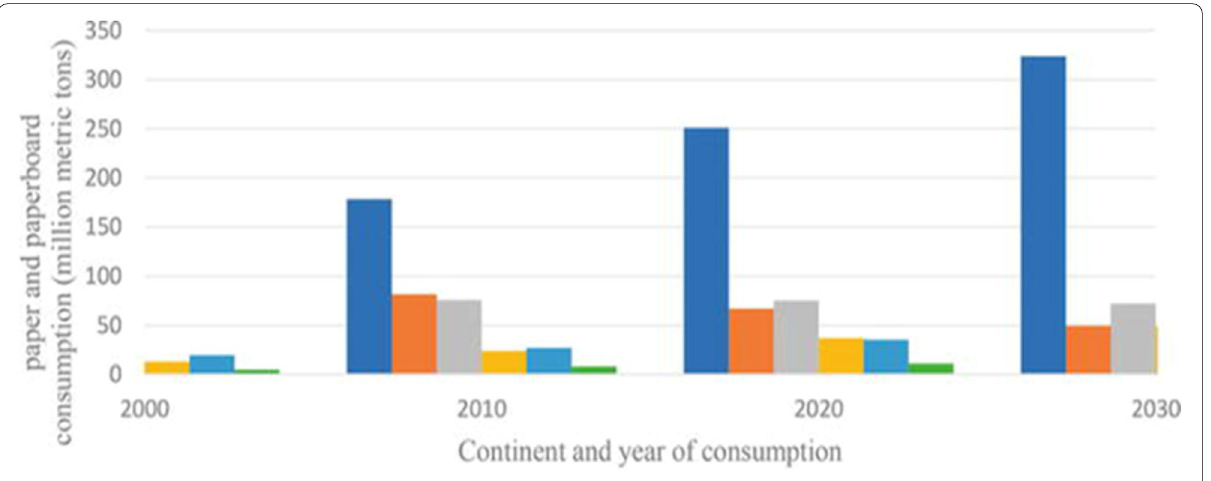
Fig. 1 Yearly trend and future forecast on world paper